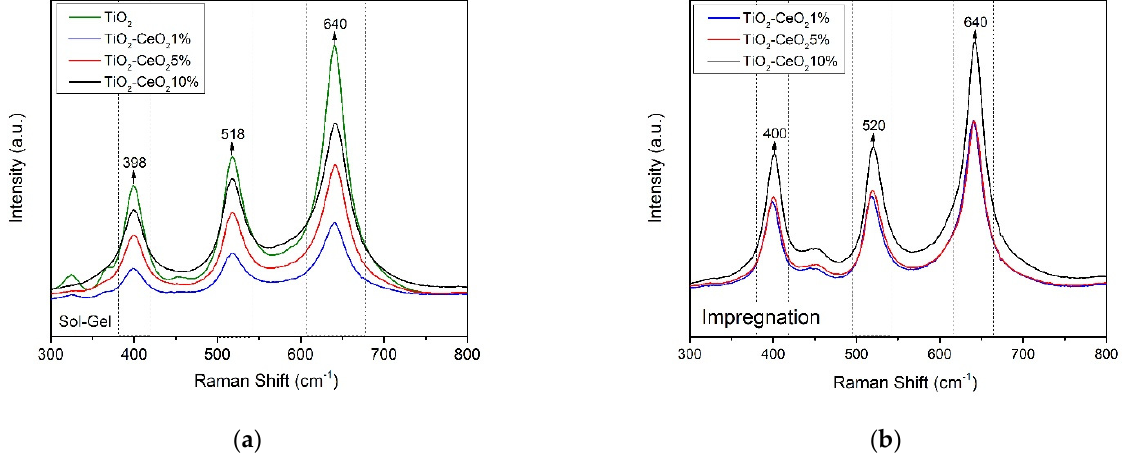
Figure 2. Raman spectrum for the support system TiO 2 , TiO 2 -CeO 2 (1, 5, 10 wt%): ( a ) Sol-gel and ( b ) Impregnation.